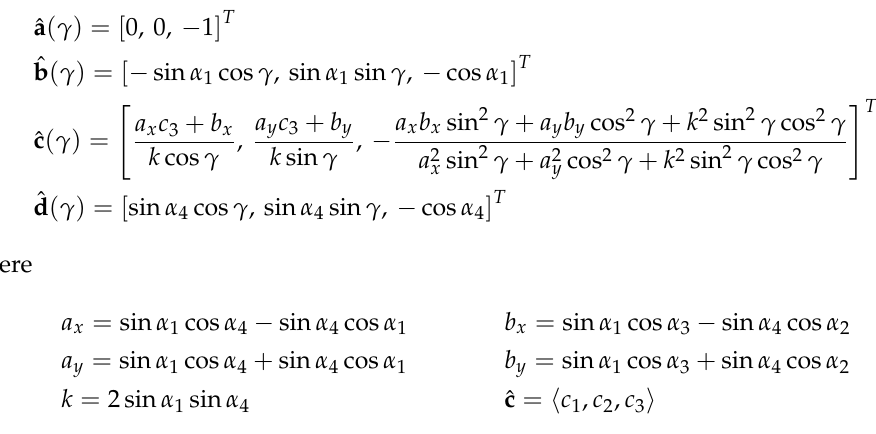
identify with X i . (Adapted from i